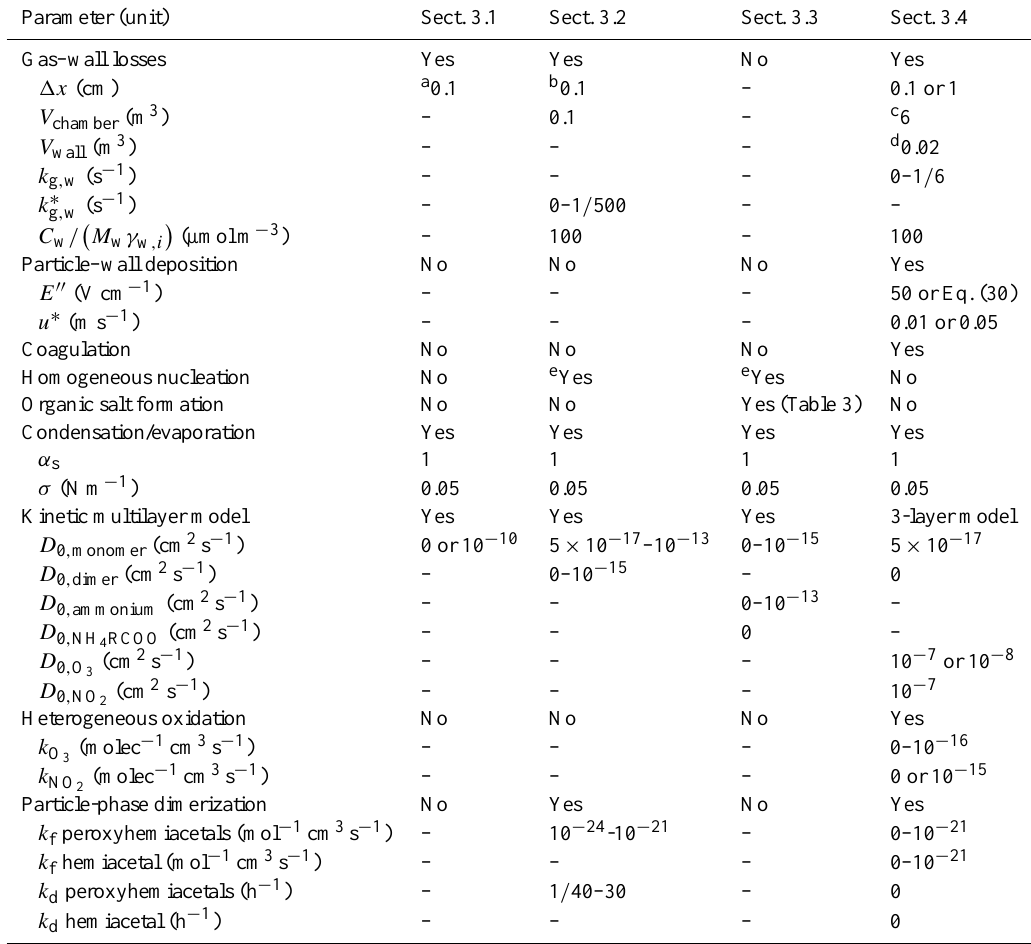
Table 2. Summary of the processes and parameter values that were used for the simulations presented in Sects. 3.1 to 3.4. Parameter